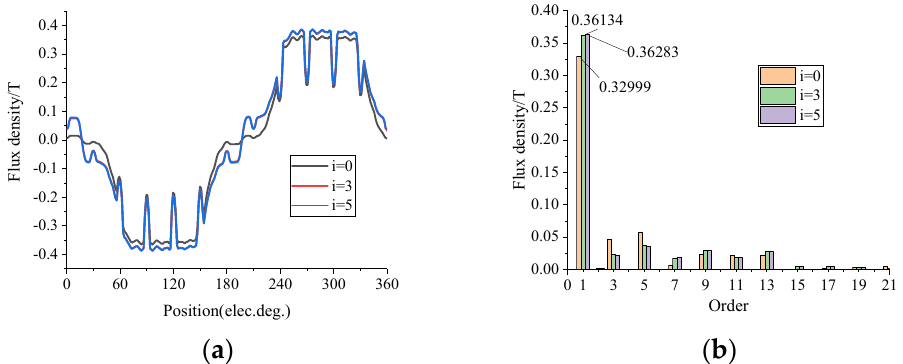
Figure 20. Air gap flux density. ( a ) Waveform of air gap flux density; ( b ) harmonic spectra.